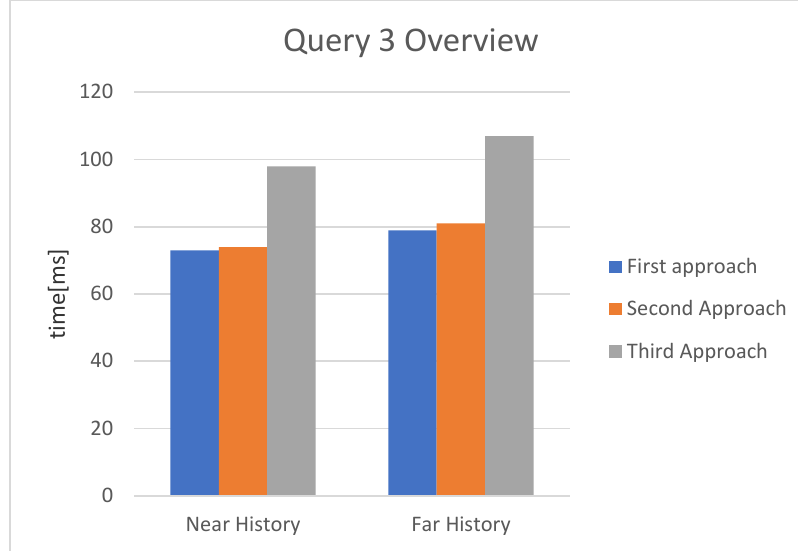
Figure 11. Results for Query 3.